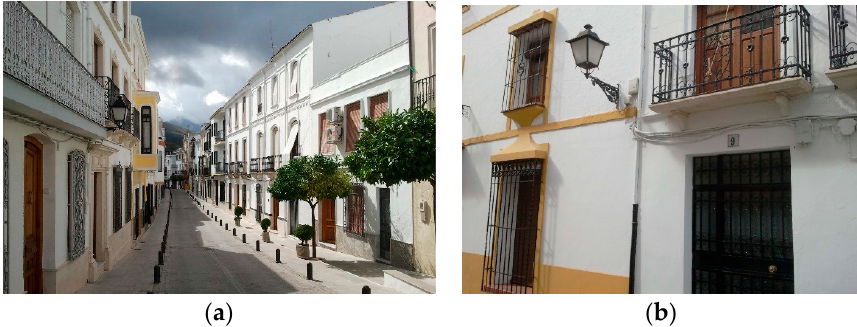
Figure 19. ( a ) General overview of the street; ( b ) Details of the lamp post installation.